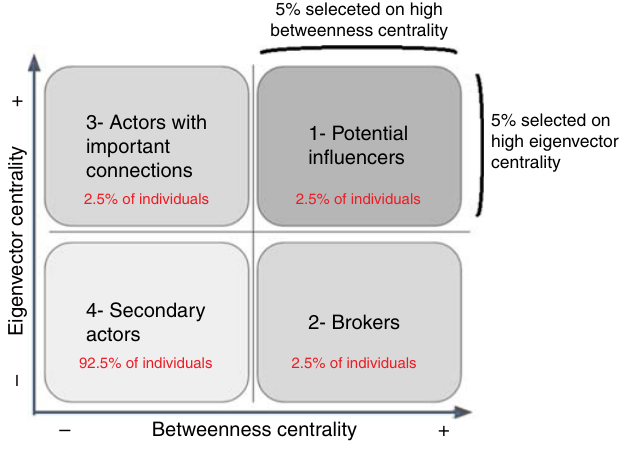
Figure 3. Matrix to detect potential influencers within a social network based on the work of Scoponi et